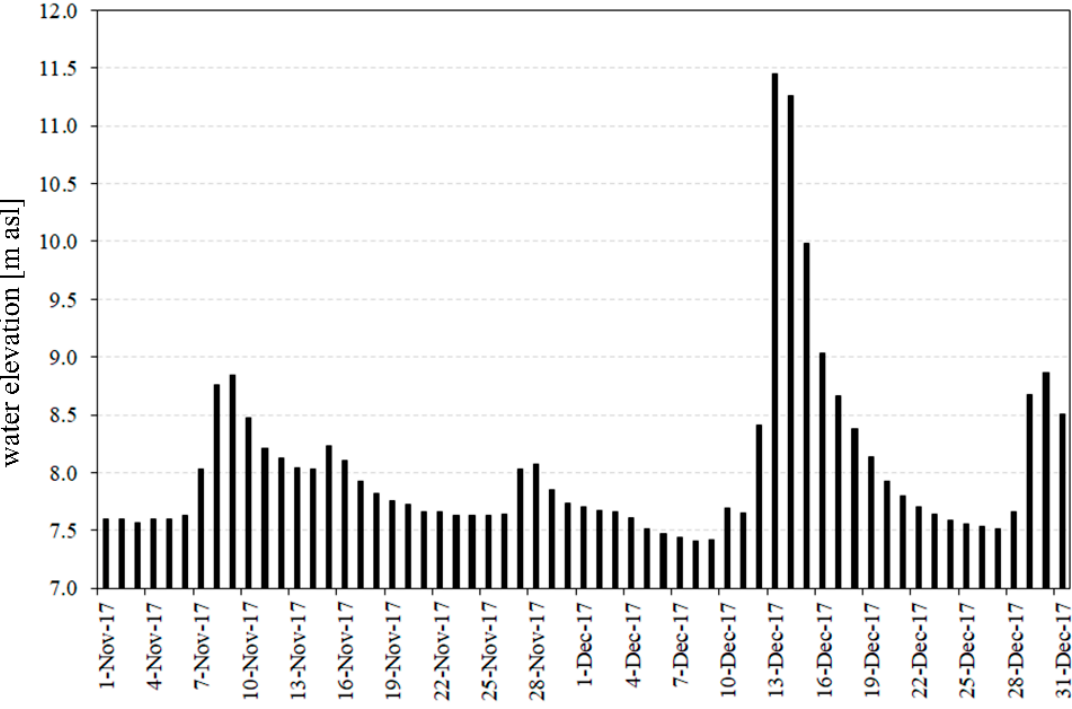
Figure 4. Water levels measured at the Revere gauging station in the analyzed period of November– December 2017. November–December